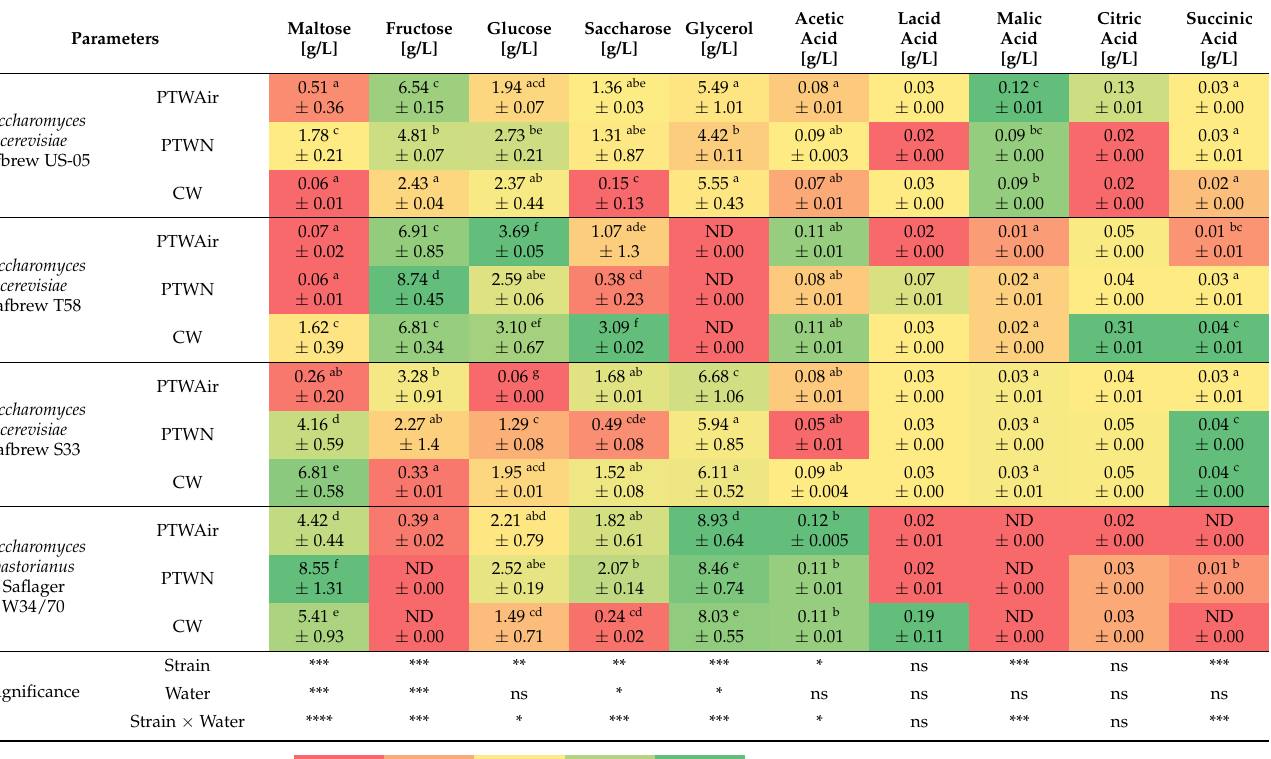
Table 3. Concentration of sugars and organic acids in beers fermented by Saccharomyces cerevisiae (T58, US-05, S33) and Saccharomyces pastorianus (W34/70) after rehydration with PTWAir, PTWN and control water